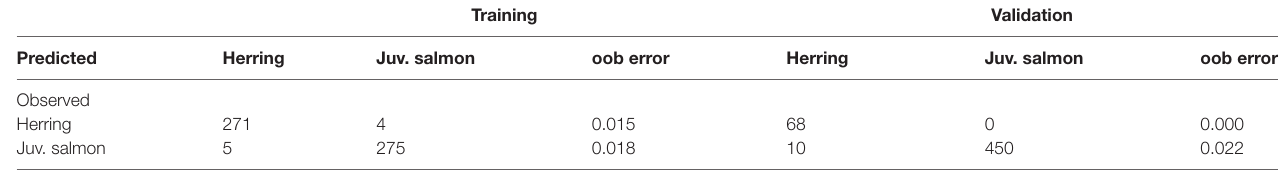
TABLE 4 | Confusion matrix for random forest generated using training dataset of 555 and validation dataset of 528 randomly selected regions.